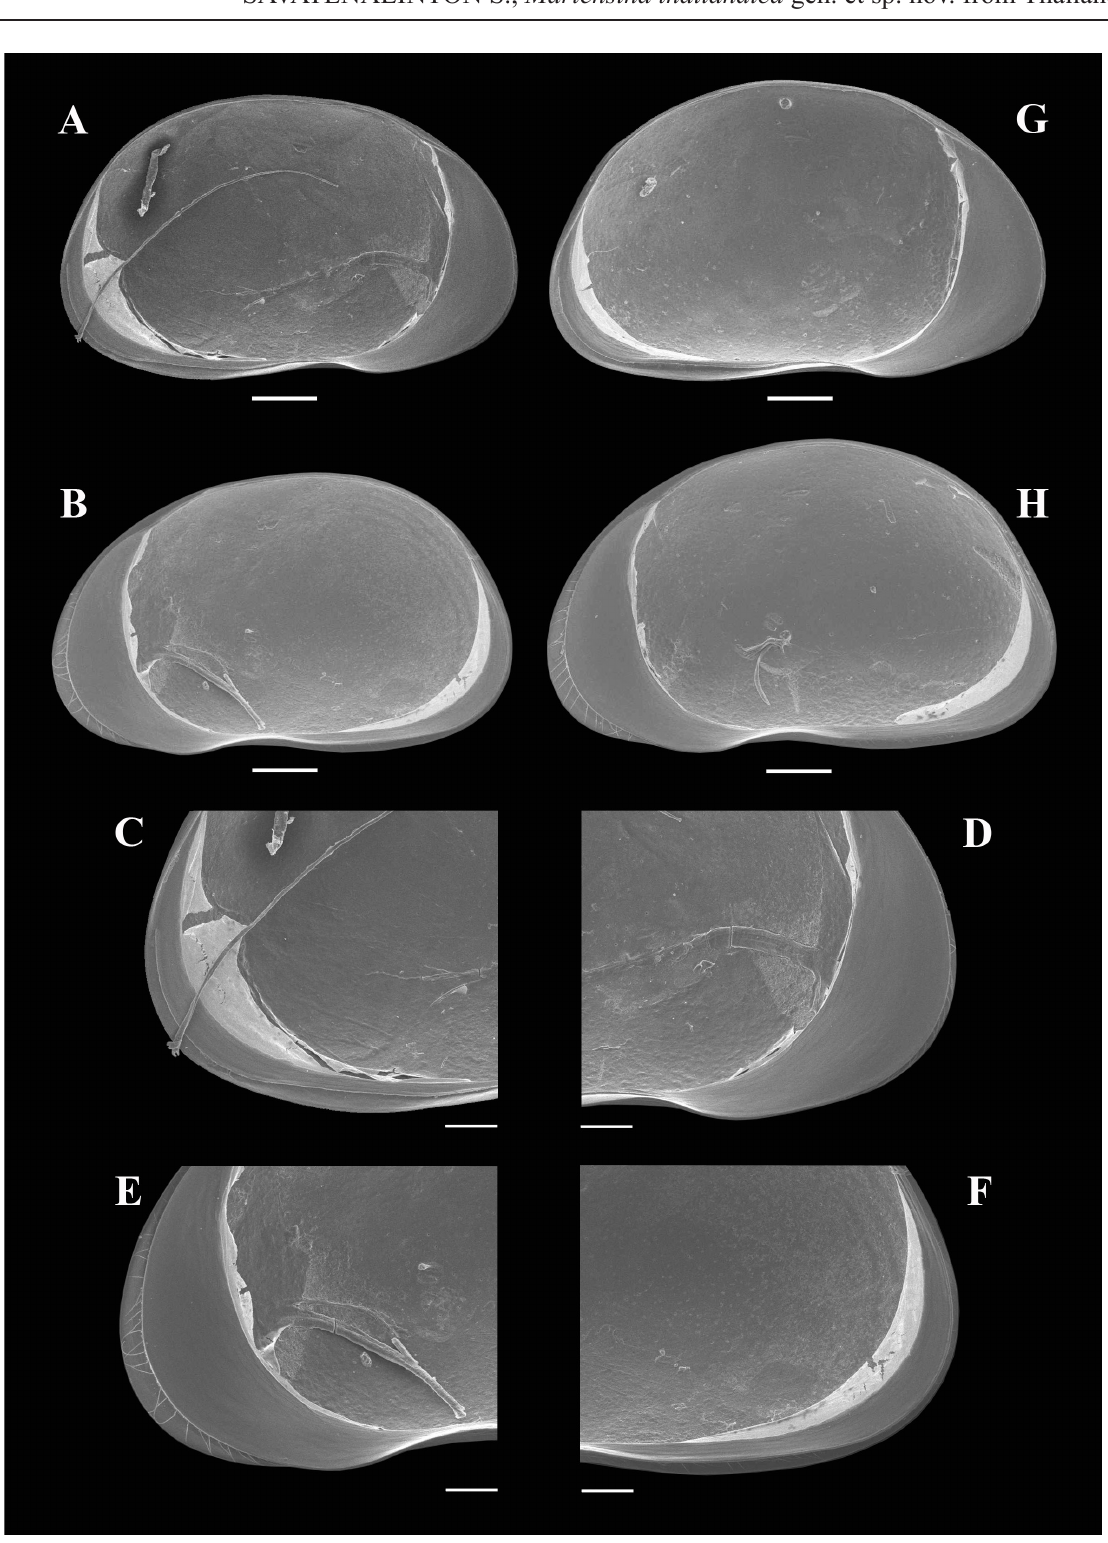
Fig. 2. Martensina thailandica gen. et sp. nov. A–F . Paratype, ♂ (MSU-ZOC.319). G–H . Allotype, ♀ (MSU-ZOC.318). A . LV, internal view. B . RV, internal view. C . LV, internal view, posterior part. D . LV, internal view, anterior part. E . RV, internal view, anterior part. F . RV, internal view, posterior part. G . LV, internal view. H . RV, internal view. Scale bars: A–B, G–H = 200 μm; C–F = 100